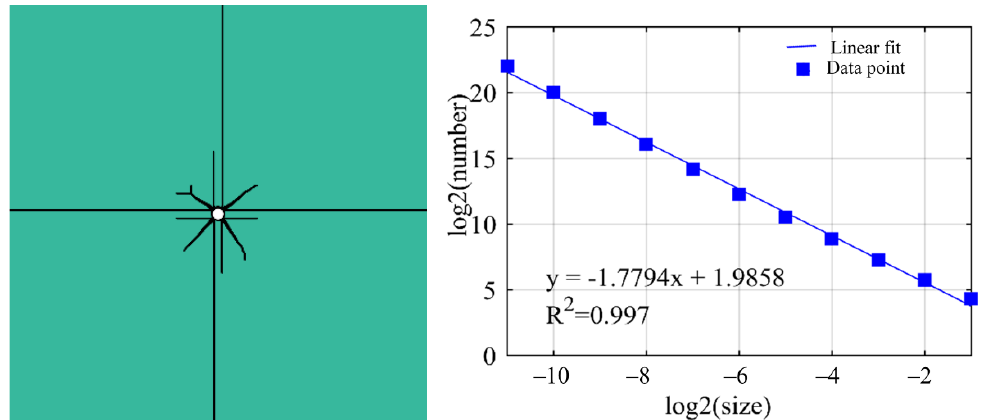
Figure 15. Distribution and fractal characteristics of CDPTB fractures.